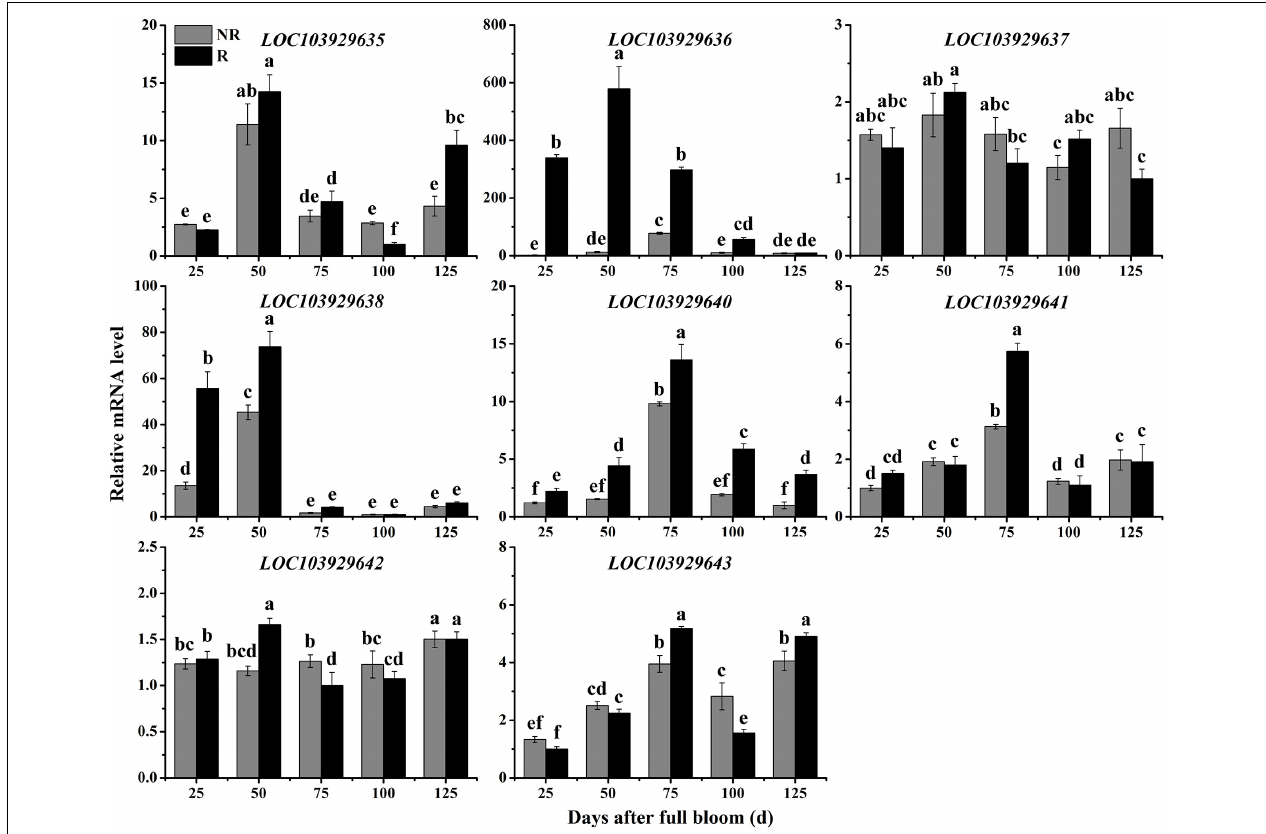
FIGURE 4 | Relative expression levels of LOC103929635 , LOC103929636 , LOC103929637 , LOC103929638 , LOC103929640 , LOC103929641 , LOC103929642 , and LOC103929643 in fruit skins of F 1 progeny from the cross between ‘Niitaka’ (russet skin pear cultivar, NTK) and ‘Dangshansu’ (non-russet skin pear